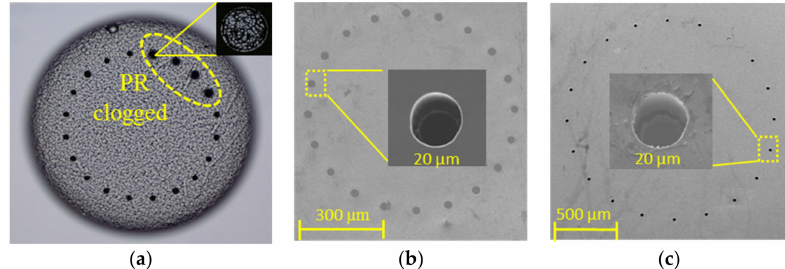
Figure 6. Nozzles etched using different mask methods. ( a ) Nozzles clogged using AZ4620 as a deep reactive ion etching (DRIE) mask; ( b , c ) Etched nozzles with the silica mask method in L1 ( b )